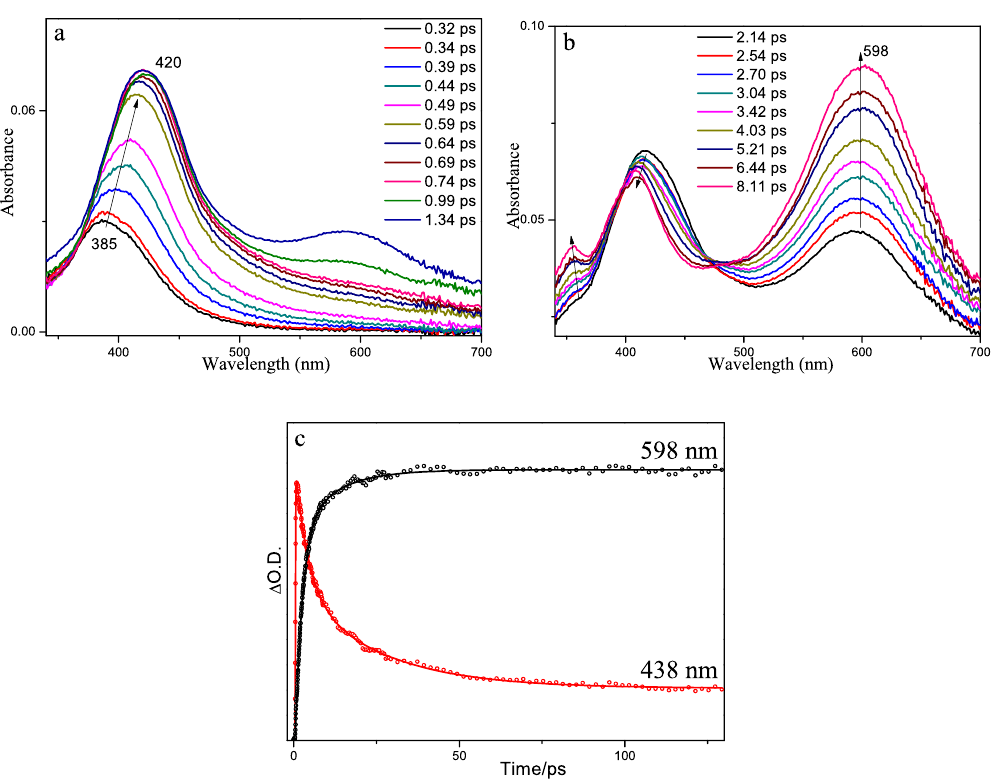
Figure 4. ( a and b ) The fs-TA spectra and ( c ) the temporal dependence of transient absorption at 438 and 598 nm for PPAQ in MeCN are